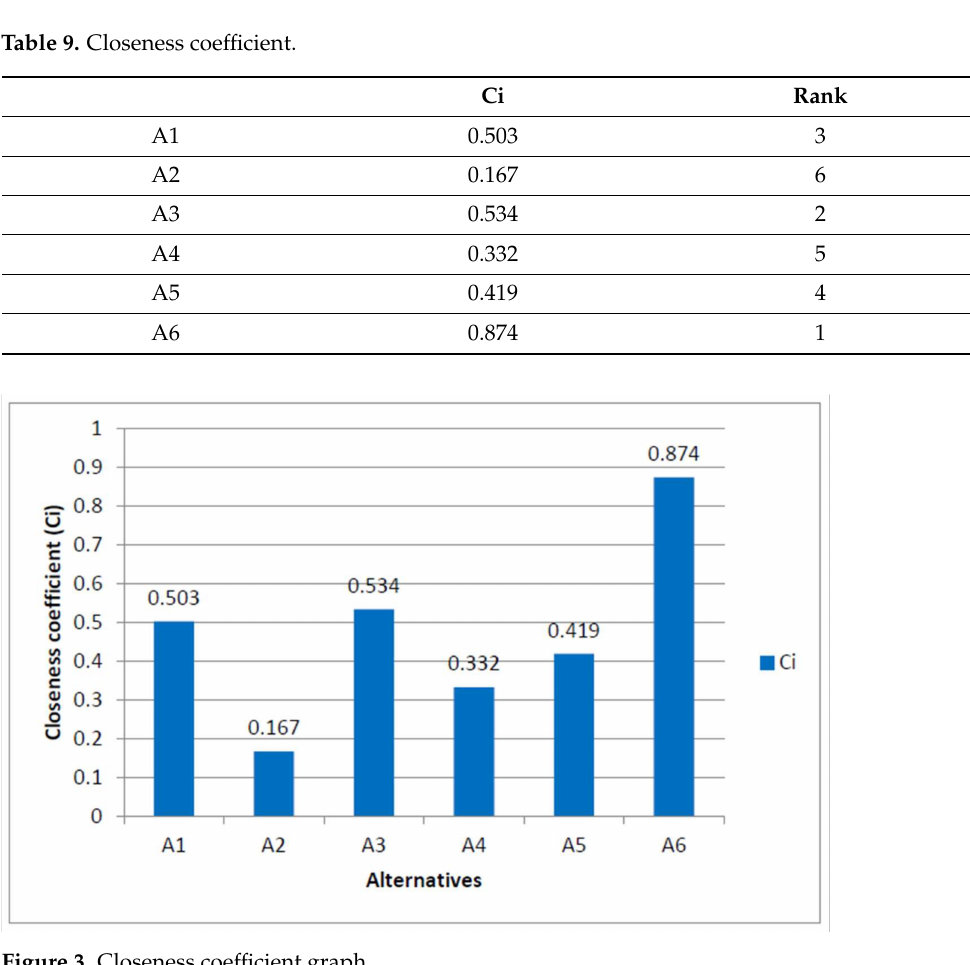
Figure 3. Closeness coefficient